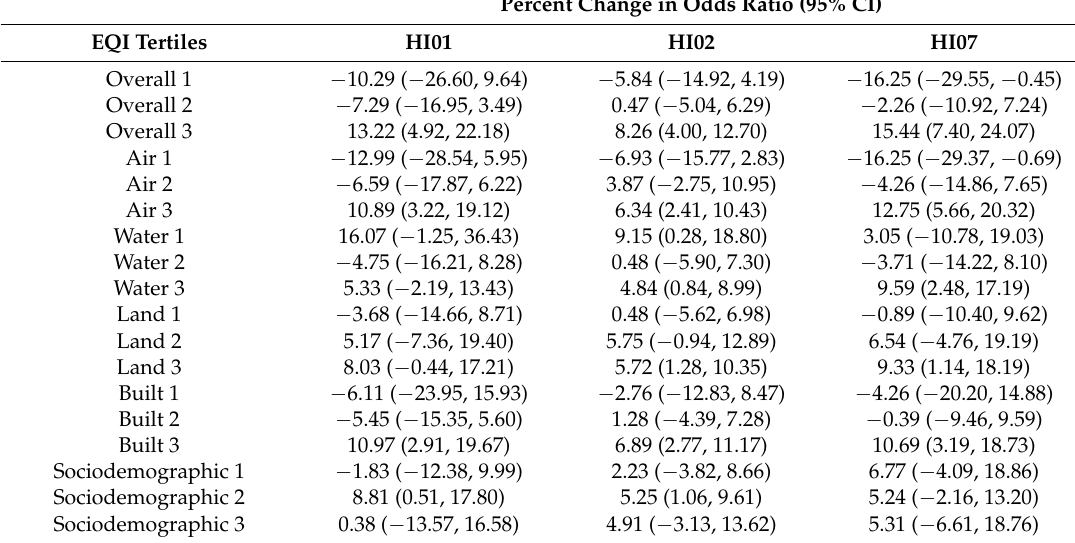
Table 2. Percent change in odds ratio (mean and (95% CI)), comparing heatwave days and non-heatwave days by tertiles of overall EQI and EQI domain indices, in metropolitan counties in Alabama. A higher EQI tertile represents a worse environmental